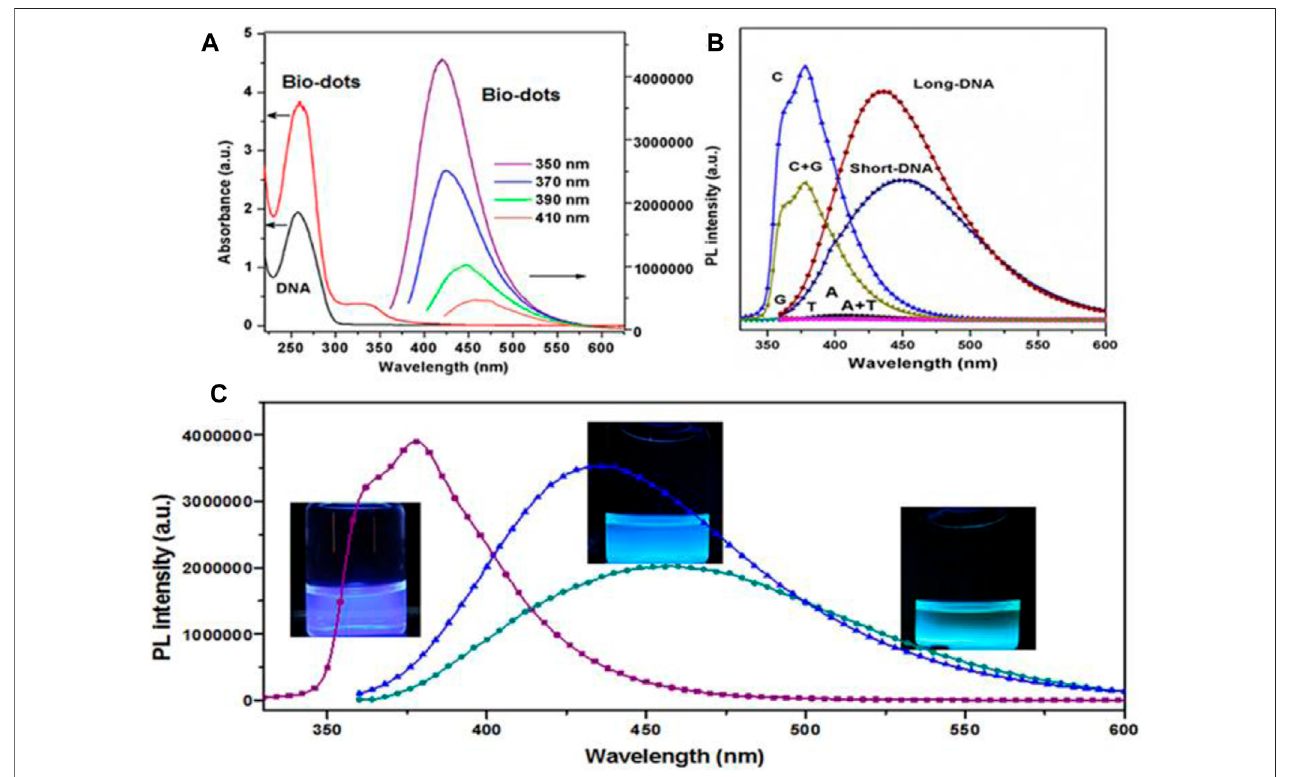
FIGURE 5 | Schematic for optical characterization of DNA biodots: (A) UV-Vis absorption spectra for precursor DNA solution and biodots and excitation independent PL spectra for biodots. (B) PL spectra for biodots derived from different precursors and (C) Biodots with different emission spectra (Guo et al., 2013).